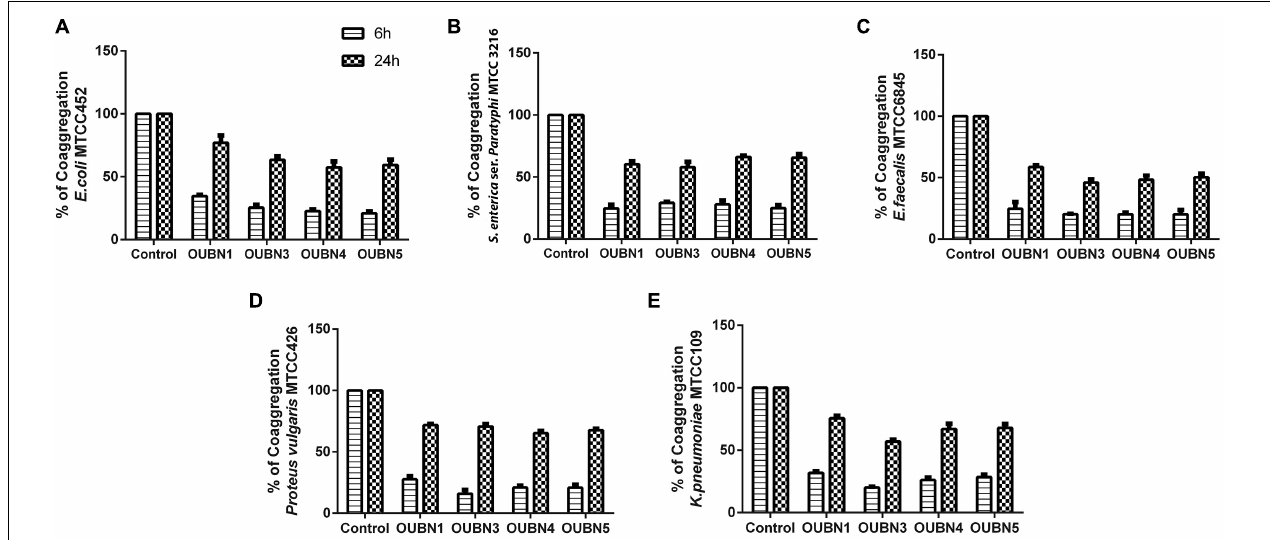
FIGURE 2 | (A) Assessment of Auto aggregation and hydrophobicity of LAB isolates. (B) Percentage of coaggregation by selected LAB isolates after 6 and 24 h against enteric pathogens (A) Escherichia coli MTCC 452. (B) Salmonella enterica ser. paratyphi MTCC3216. (C) Enterococcus faecalis MTCC 6845. (D) Proteus vulgaris MTCC 426. (E) Klebsiella pneumoniae MTCC 109. Bacterial growth was monitored at OD 600 . The growth of enteric pathogens without CFS was considered as control (100%). Data shown are mean ± SD of triplicate values of independent experiments. P > 0.005.